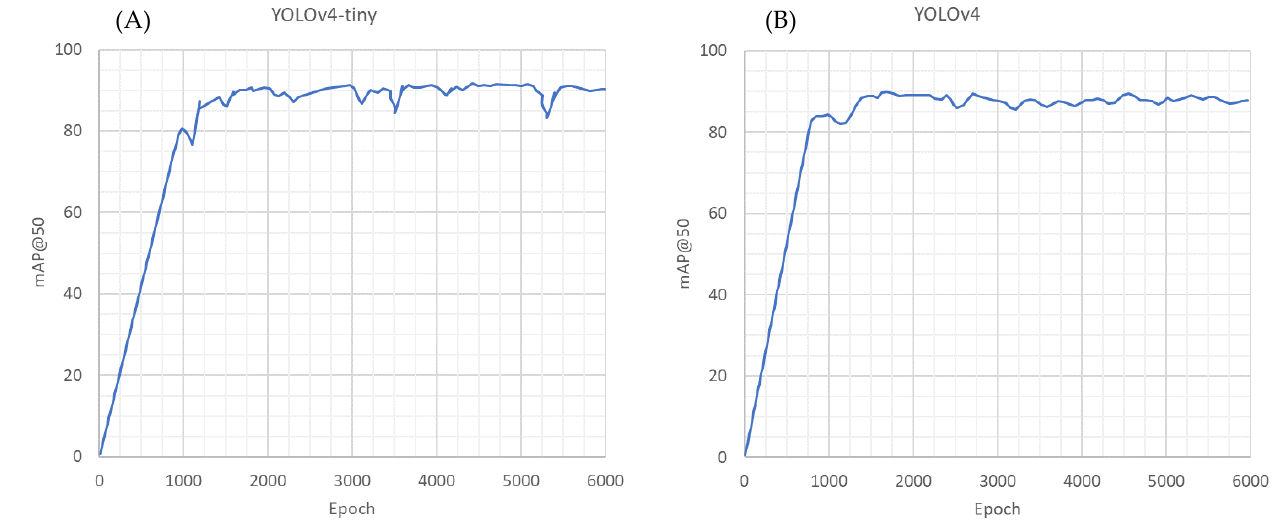
Figure 3. Area under the precision–recall curve with a grade of overlapping bounding boxes of 50% 246